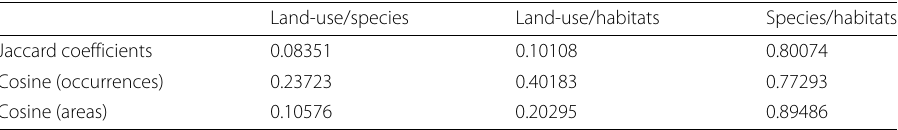
Table 5 Spearman correlation between sets of hit rates